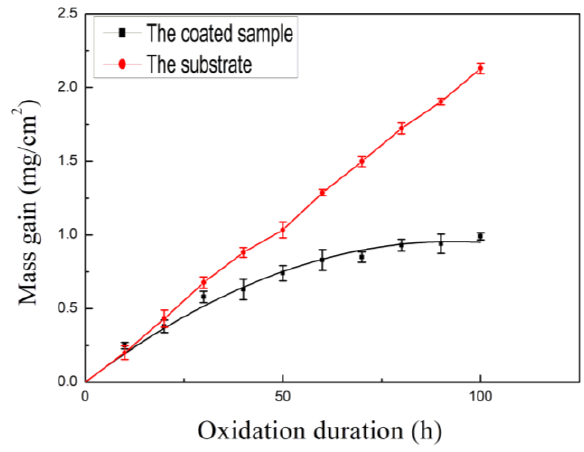
Figure 9. Oxidation kinetics curves of Ti alloy with and without coating at 1073 K for 100 h (10 cycles).